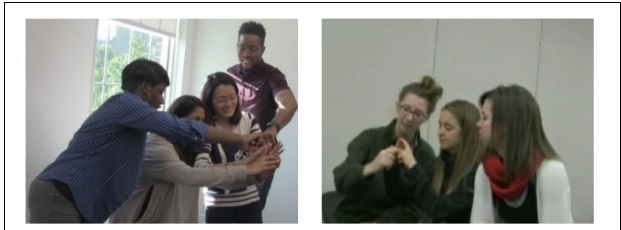
FIGURE 5 | Collaborative gestures used to create a dynamic diagram for a math